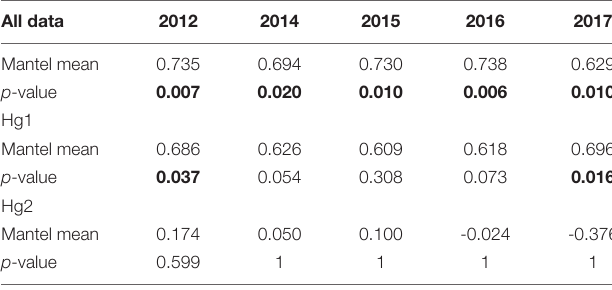
TABLE 6 | Congruence among distance matrices analyses (CADM) comparing the pairwise-F ST matrices of each year with the rest of the years in all COI data, Hg1, and Hg2 in Pyura chilensis . All